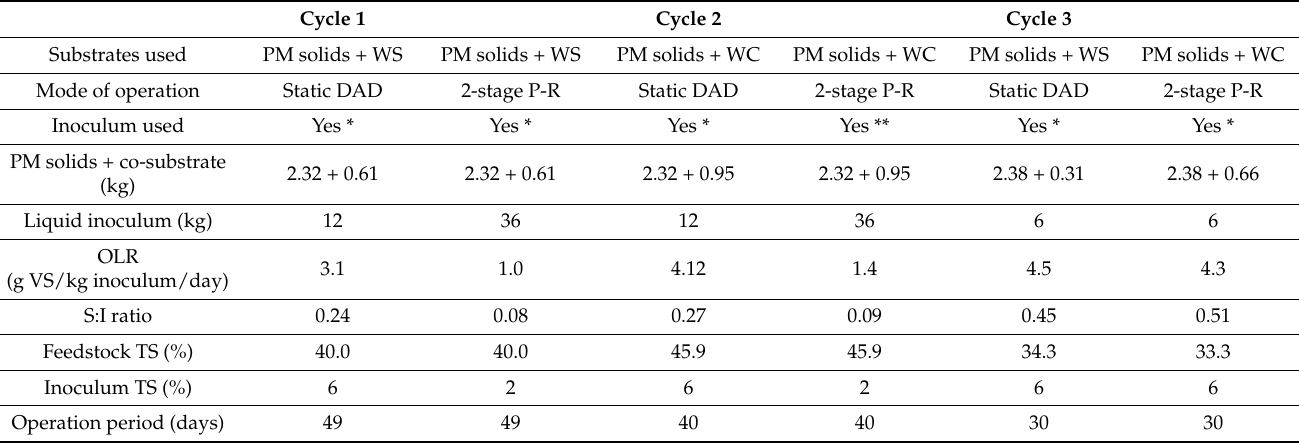
Table 3. Operating conditions and variables for all experiments in the three operation cycles.